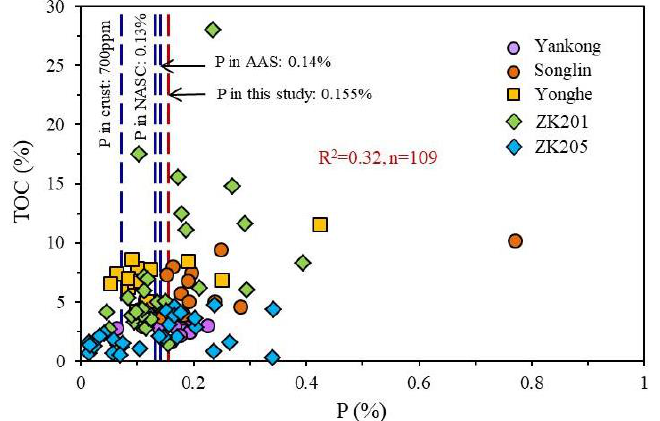
Figure 10. Plot of TOC versus P. The blue and red dotted lines indicate the average P contents of the different materials. NASC — North American Shale Composite; AAS — Average Archean Shale. different materials. NASC—North American Shale Composite; AAS—Average Archean